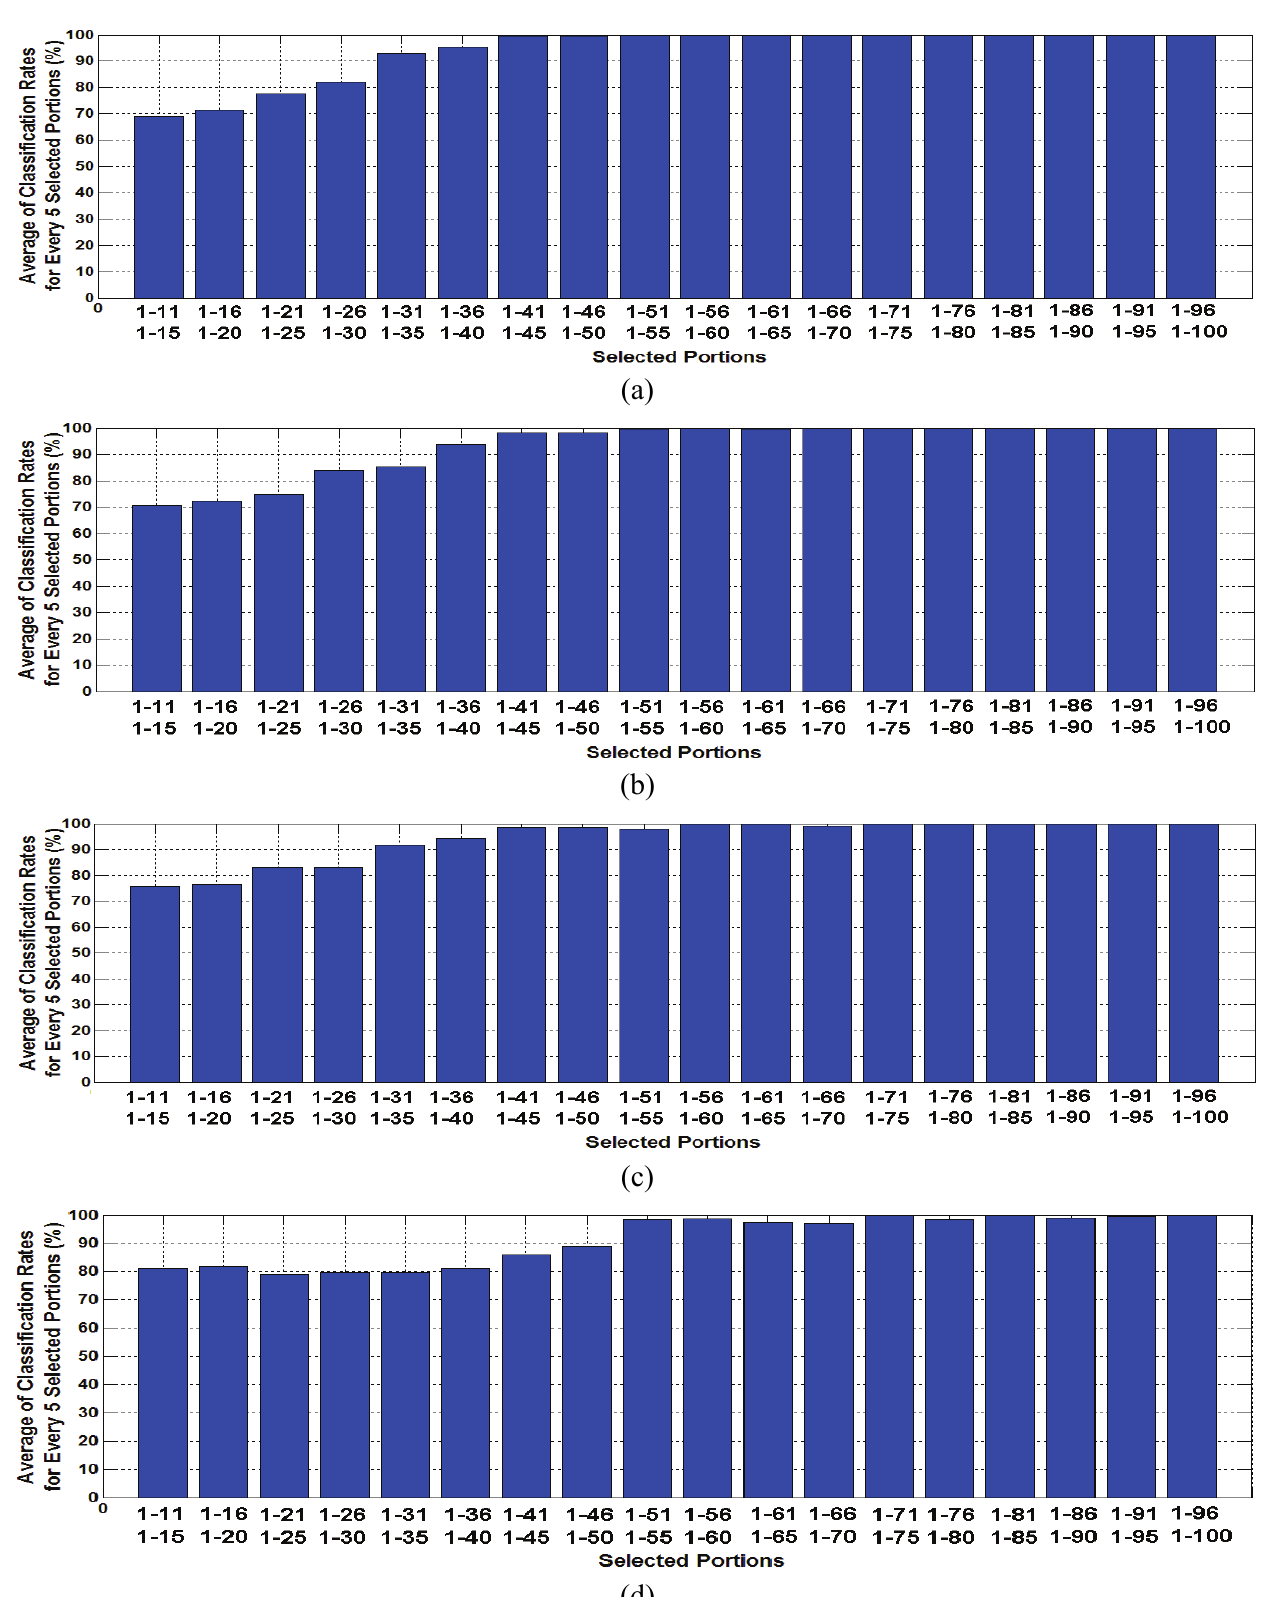
Figure 8. (a) Averages of evaluated classification rates for extracted features by LDA classified by the quadrate classifier and (b) The same for k-NN classifier. (c) The same for MLP classifier. (d) The same for SVM